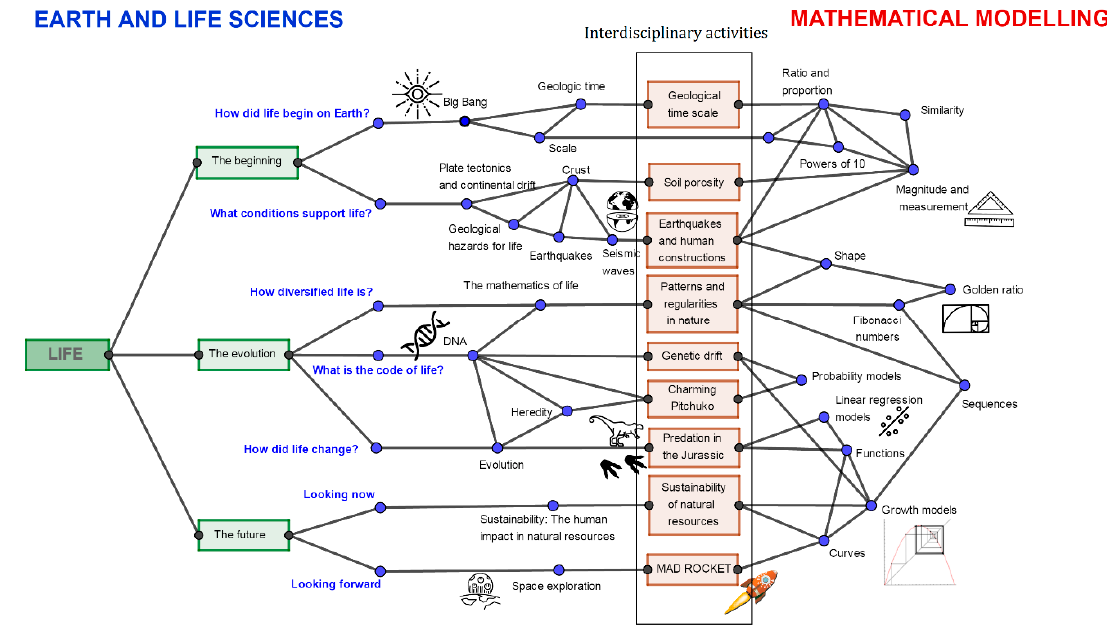
Figure 1. Conceptual network linking topics within and between the two courses. At the center there are the interdisciplinary activities that promote the integrative approach of both